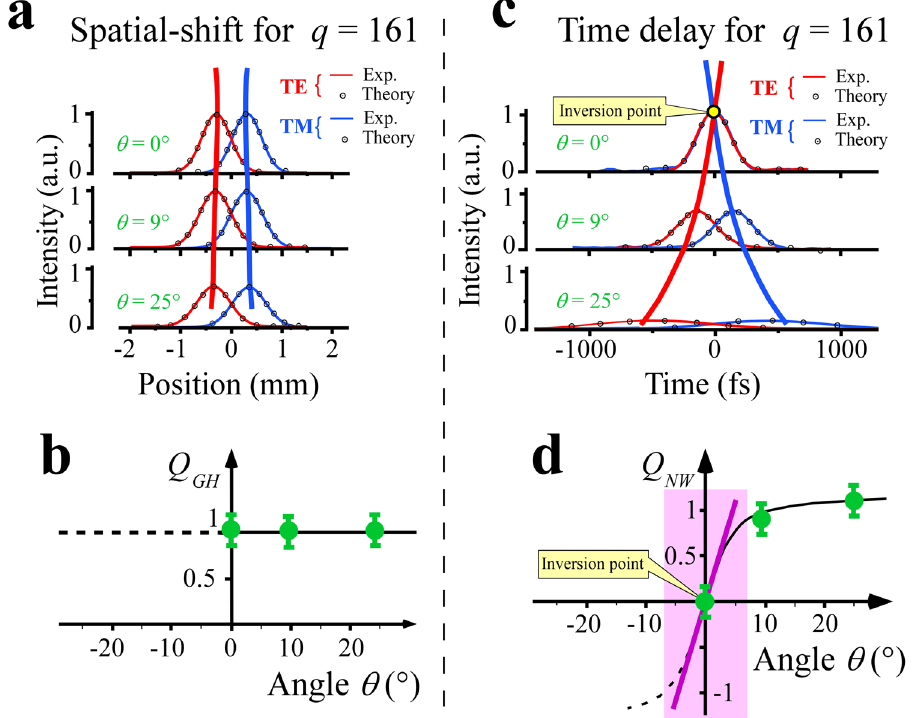
Figure 3. Respective dynamics of the measured spatial shifts and delay times. (a) Experimental and theoretical dynamics of the spatial shifts for the TE and TM polarizations for different orientations of the finish line in the plane of incidence of the waveguide. (b) Plot of the figure of merit Q for the different measurements showing the invariance of the Q factor versus the orientation of the detection line. ( c ) Corresponding responses for the delay times. The measured value for θ = 9° leads to a Newton-Wigner delay value along the interface of 2595 ± 30 fs. Note here, the existence of an inversion point where the sign of the measured delay times changes. (d) The corresponding factor of merit Q shows large variations around the inversion point schematized by the purple